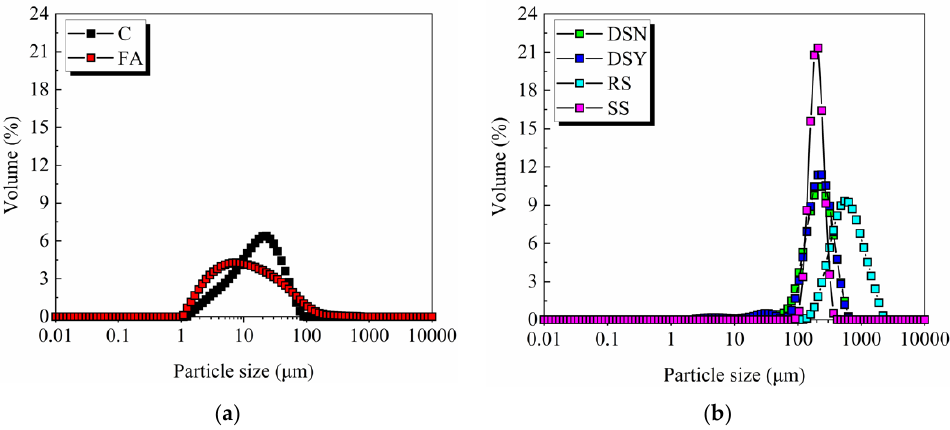
Figure 1. Particle size distributions of raw materials. ( a ) Powder material. ( b ) Different fine aggre- gates.